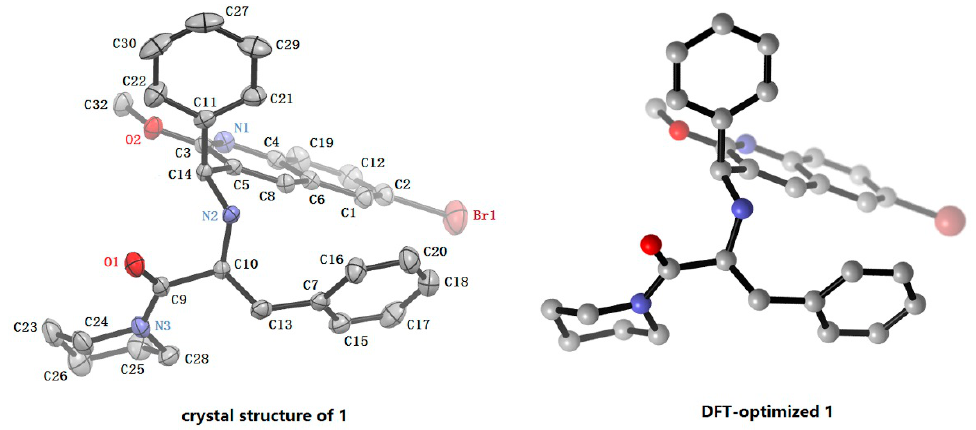
Figure 4. DFT-optimized and crystal structure of 1 , displacement ellipsoids are drawn at the 30% probability level. Table 2. Crystal data and refinement details for compound 1 .